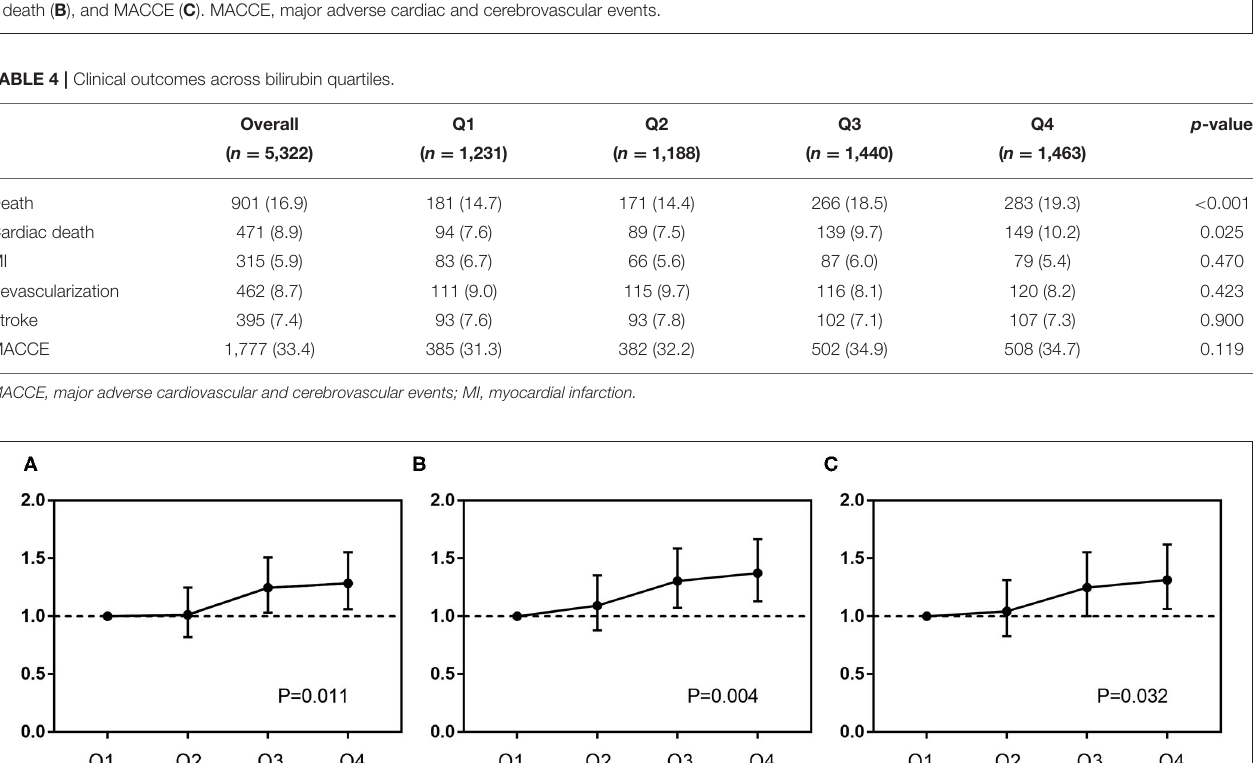
FIGURE 2 | Kaplan–Meier curves of the primary and secondary endpoints across DB quartiles ( A – C ). Cumulation incidence curves for all-cause death ( A ), cardiac death ( B ), and MACCE ( C ). MACCE, major adverse cardiac and cerebrovascular events.